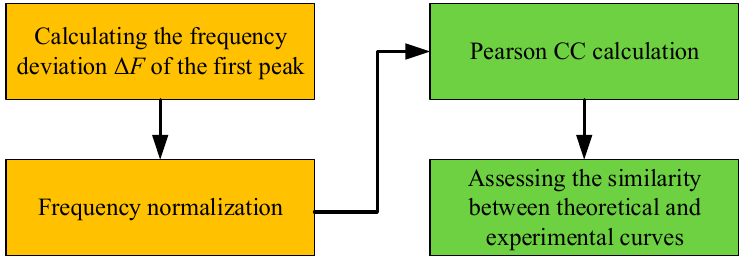
Figure 7. Flowchart of similarity assessment between theoretical and experimental curves.